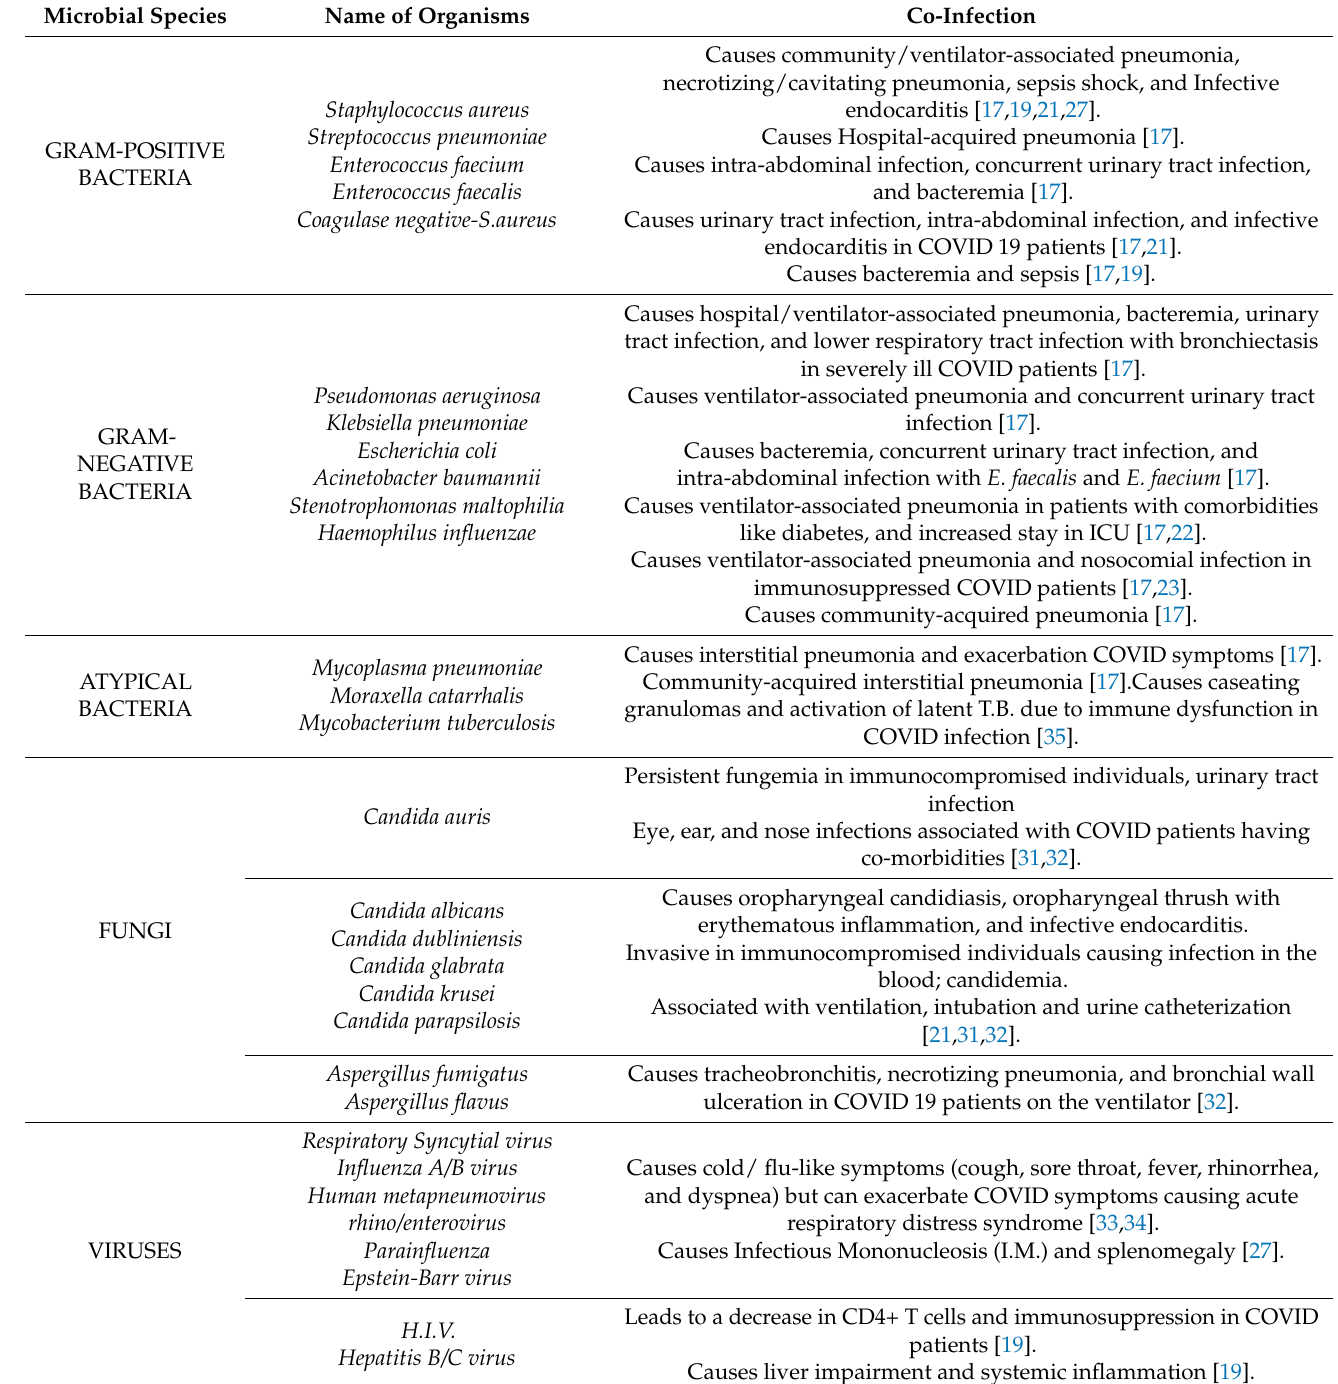
Table 2. Microbial co-infection in